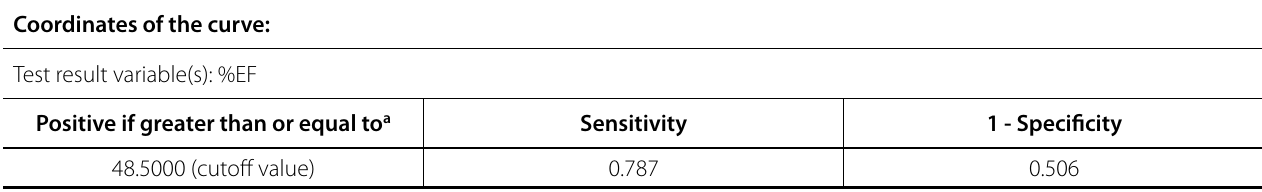
Table 6 . Coordinates of the curve for ejection fraction (EF) values – postoperative sinus rhythm. Coordinates of the curve: